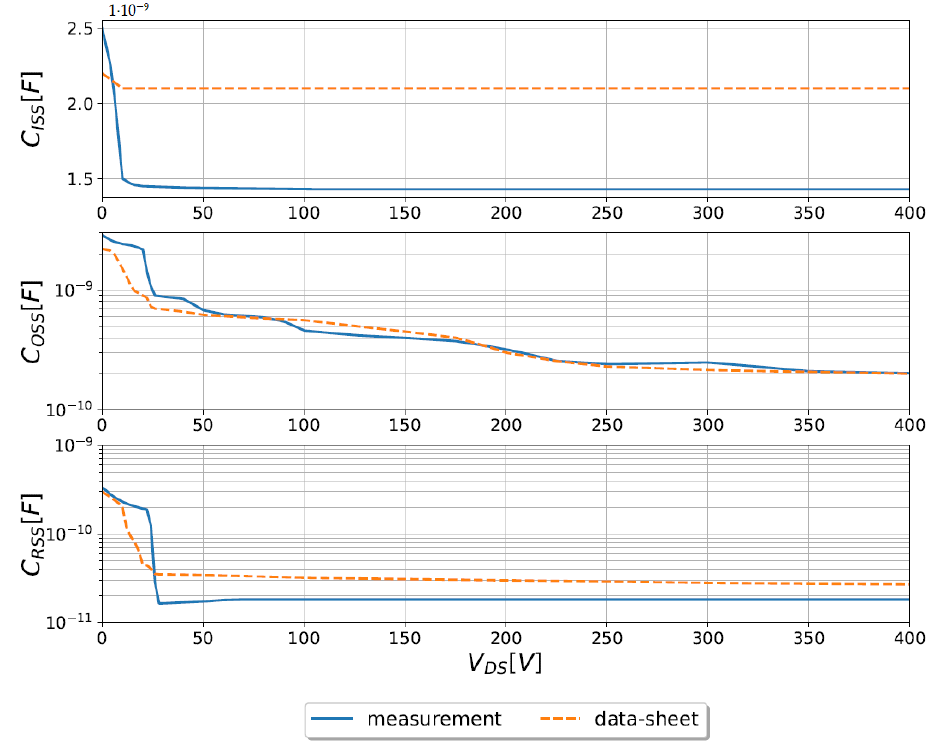
Figure 4. TPH3207WS GaN